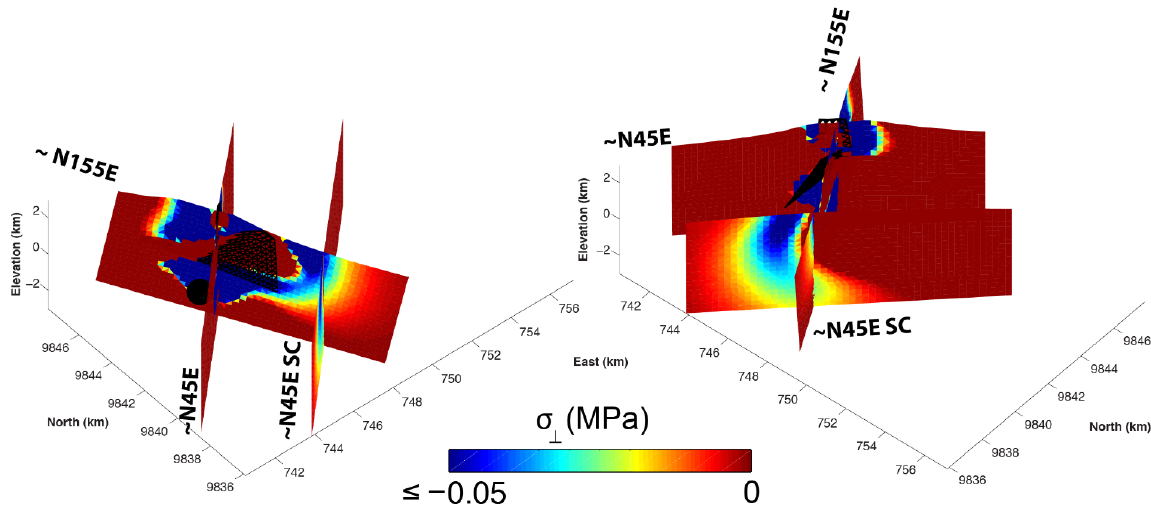
Figure 6. Perspective plots from two orthogonal viewing angles showing the changes in the normal stress on the potential dike surfaces (Figure 4) caused by the preferred model of the 2010 best-fitting deformation sources (black mesh). The color scale corresponds to normal stress change in MPa, with positive values (clamping) clipped to dark red and negative values (unclamping) from blue to red. SC stands for south of the caldera. Both the N155 and N45E SC dike surfaces are unclamped over large and deep areas beneath the volcano by the 2010 eruption sources, while only a small area of the N45E (caldera intersecting) surface is